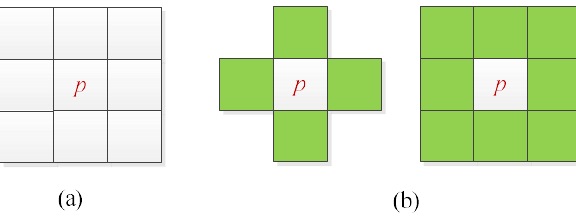
Figure 3. ( a ) Square template for seed point detection. ( b ) 4-neighborhood and